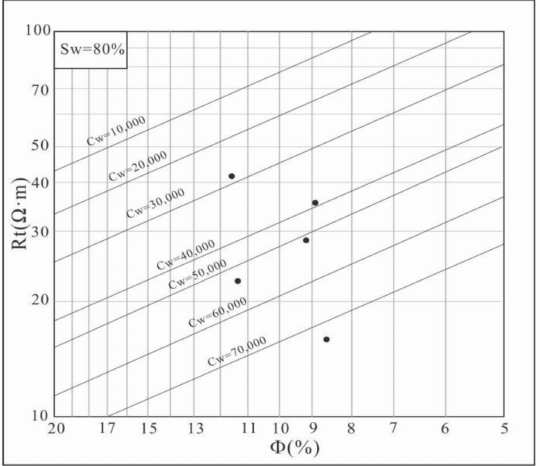
Figure 11. Modified resistivity–porosity base plate under variable salinity conditions ( S w =